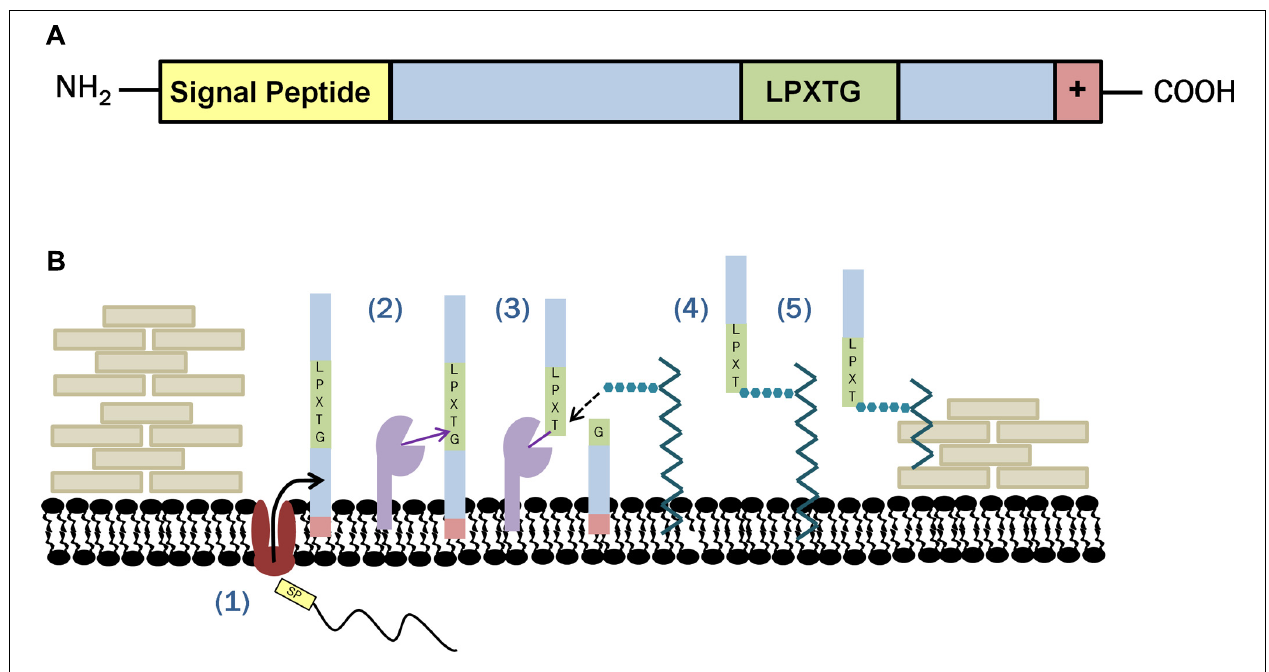
terminated by a charged tail. (2) Once sortase and the sortase substrate are in proximity, sortase cleaves the target between the glycine and threonine residues via a transpeptidase reaction. (3) Nucleophilic attachment by lipid II disassociates the sortase/SDP complex and (4) forms a lipid II intermediate through interaction with the pentapeptide cross bridge. (5) In the final stages of sortase anchoring, the sortase substrate is incorporated into the cell wall as part of normal cell wall construction (adapted from Hendrickx etal.,